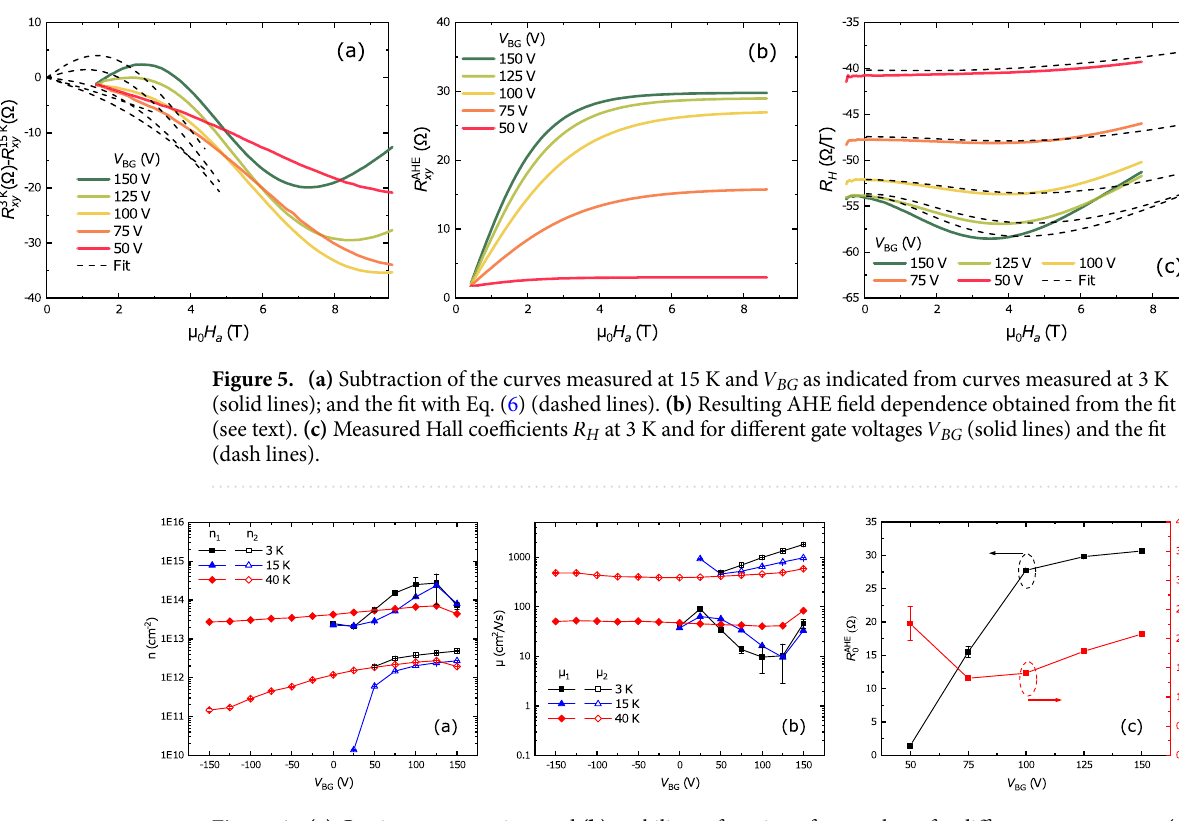
Figure 6. (a) Carrier concentration, and (b) mobility as function of gate voltage for different temperatures. (c) Anomalous Hall coefficient R AHE 0 (black) and magnetic moment per atom µ B (red) versus back gate voltage at 3